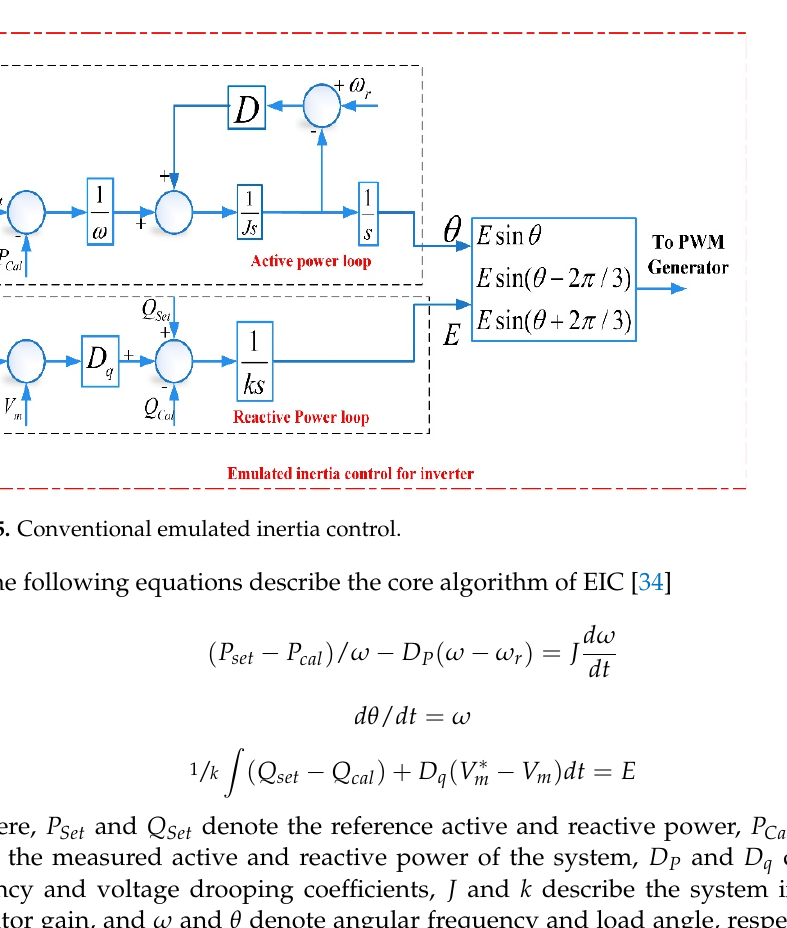
Figure 6. Overview of fuzzy logic structure. 4.2. Fuzzy Inputs and Outputs The effective performance of the fuzzy system is strongly dependent on the accurate selection of the inputs. Frequency deviation ( f Δ ) and ROCOF are the key parameters that can impact inertial response, and these are selected as inputs for the fuzzy system to